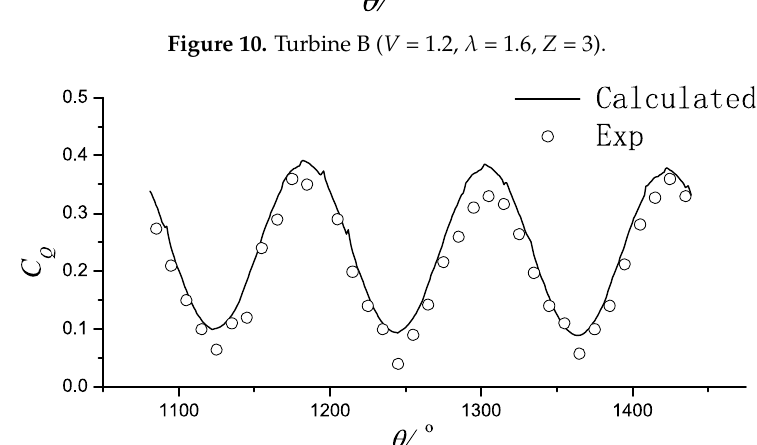
Figure 12. Turbine C ( V = 1.2, λ = 1.65, Z = 5). Figure 13. Turbine C ( V = 1.2, λ = 2.23, Z = 5).